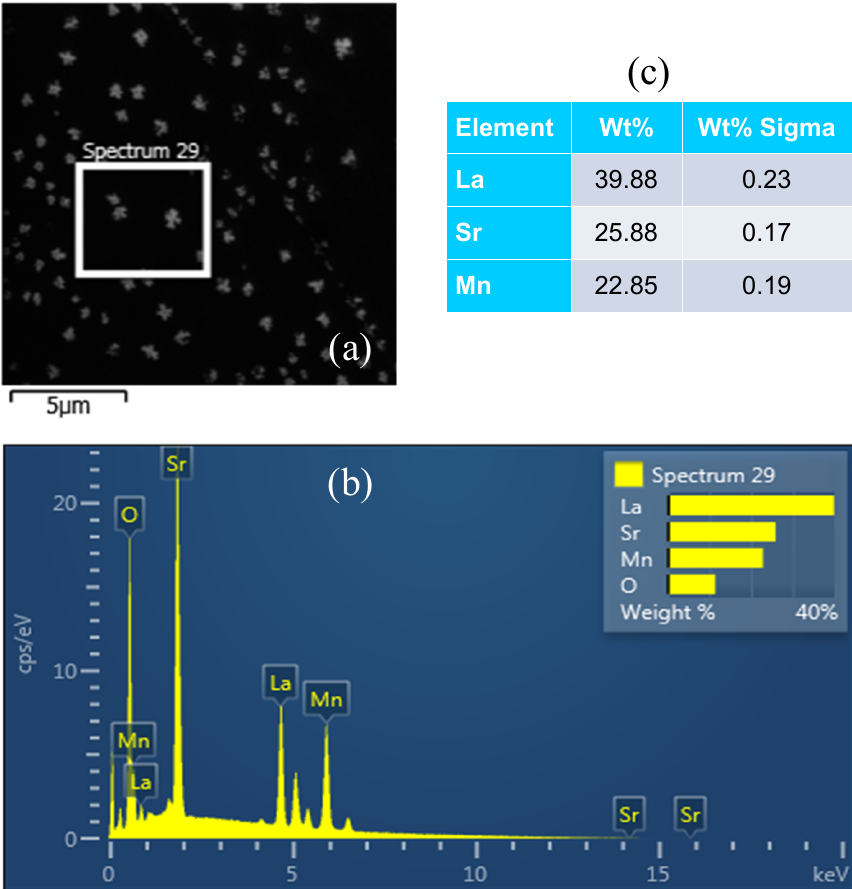
Figure 5. ( a ) Scanning electronic microscopy image of a cleaved La 1.37 Sr 1.63 Mn 2 O 7 single crystal. The scale bar represents 5 µ m; ( b ) the energy-dispersive X-ray chemical composition analysis of the selected area that is marked in (a) (the square); ( c ) extracted weight percentage (Wt%) of the chemical compositions of La, Sr, and Mn elements as well as the corresponding error bars (Wt% Sigma). We ignored the composition analysis of